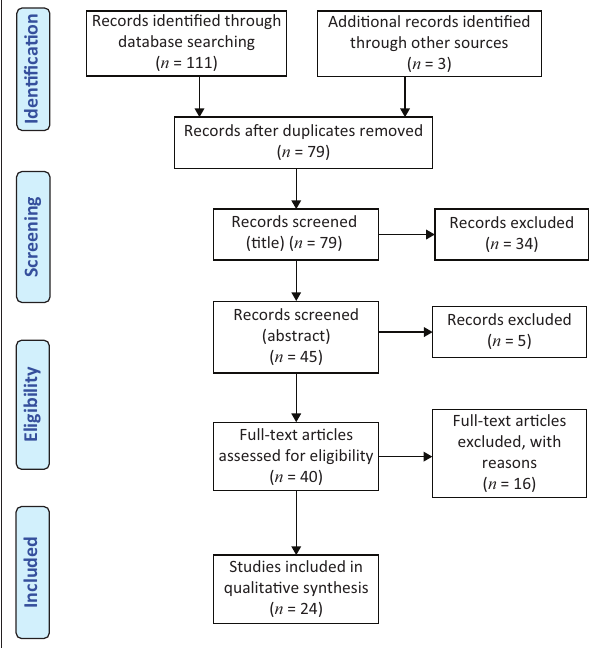
FIGURE 1: Preferred Reporting Items for Systematic Reviews and Meta-Analysis flow diagram for the current scoping